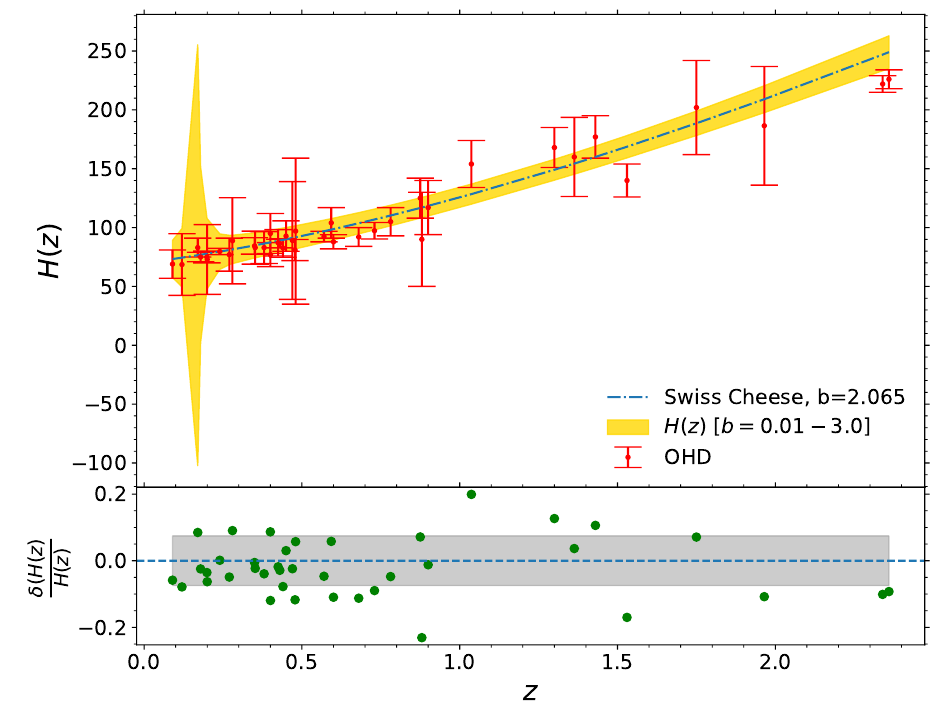
Figure 6. Plot of the best fit Hubble parameter value of our Swiss-cheese model, H ( z , b = 2.065 ) (green dashed) against the redshift binned OHD with their corresponding error bars (red) for z = [0–2.4]. The yellow margin represents the extent of the H ( z , b ) values of our model when b is varied between 0.01–3.0 across the full redshift range. The bottom plot shows the ratio of the error between the OHD data (red in top panel) and the best fit Swiss-cheese data (green in top panel), i.e., δ ( H ) and the Hubble parameter (green dots). The gray-shaded margin corresponds to the mean error level ( ∼ 0.07).